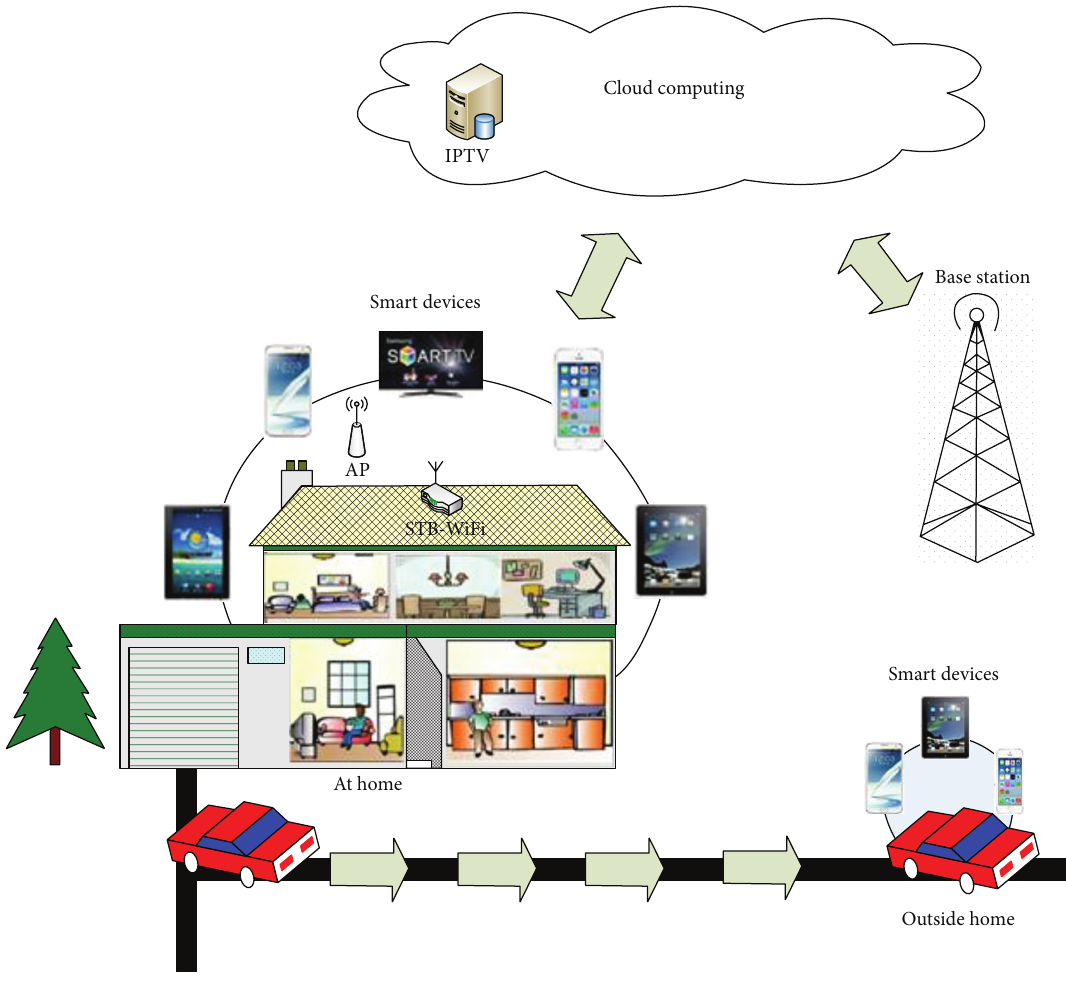
Figure 3: Service